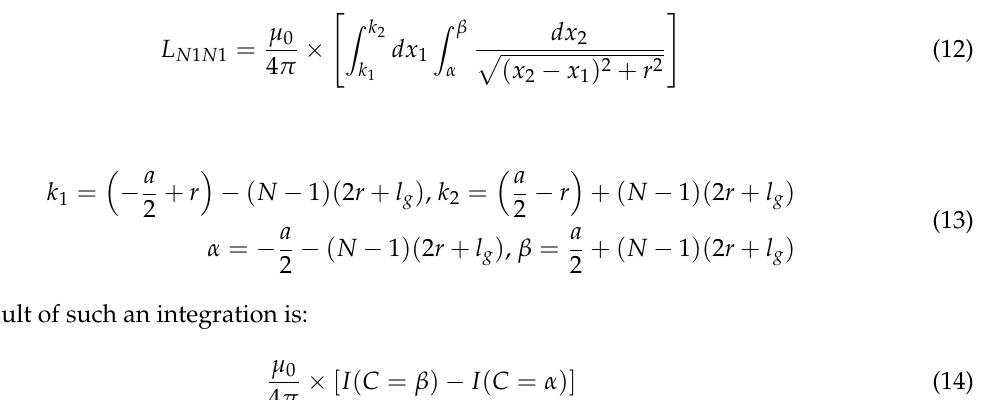
(cid:104) − a − ( N − 1 )( 2 r + l g ) , b + ( N − 1 )( 2 r + l g ) 2 2 (cid:16) (cid:17) (cid:105) b − r + ( N − 1 )( 2 r + l g ) 2